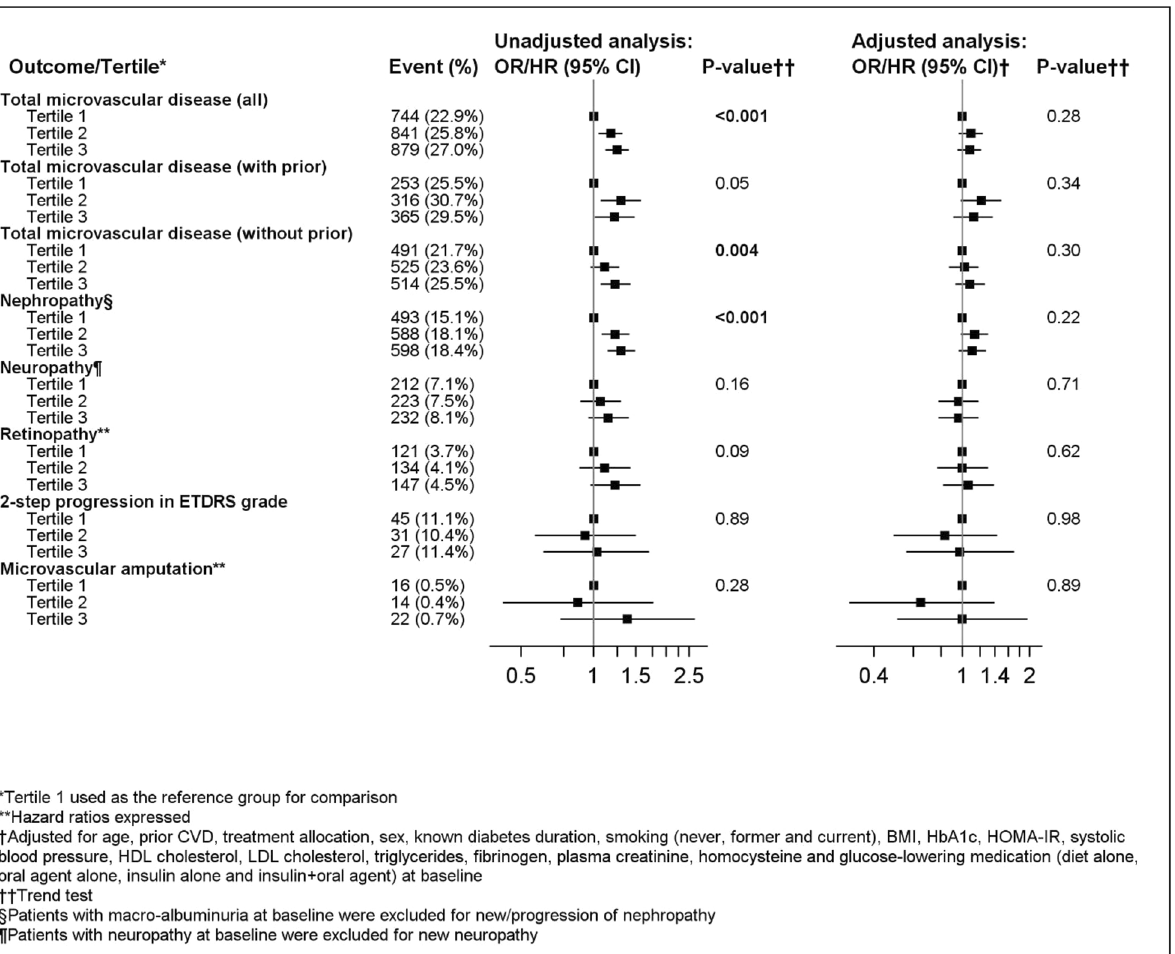
Figure 2. Association of baseline LMW-F levels with on-study microvascular events over 5